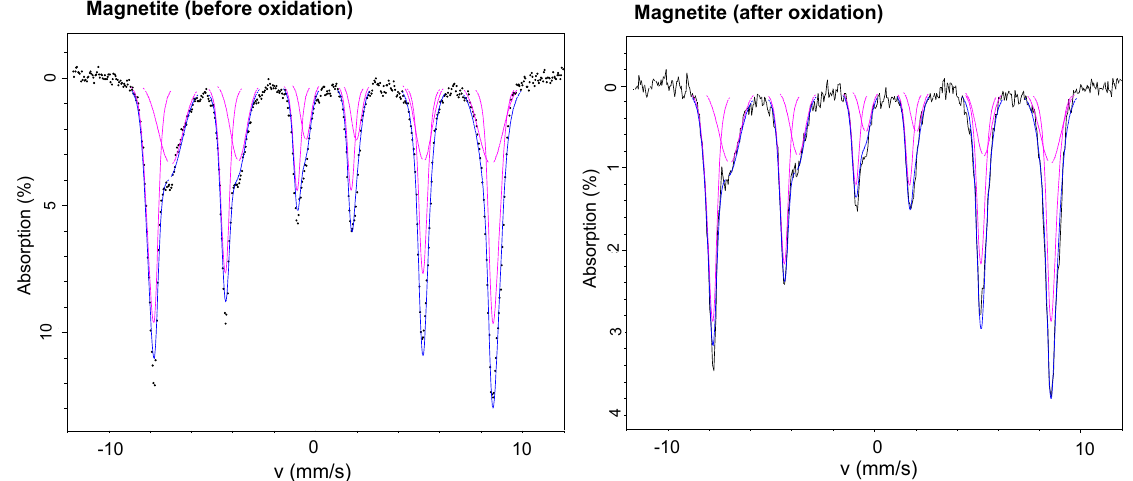
Figure 6. Mössbauer spectra of magnetite samples (before and after their use in chemical oxidation experiments) collected at 140 K. Table 3. Fitting results of Mössbauer spectroscopy. CS — center shift. e — quadrupole shift. H — hyperfine field. stdev(H) —